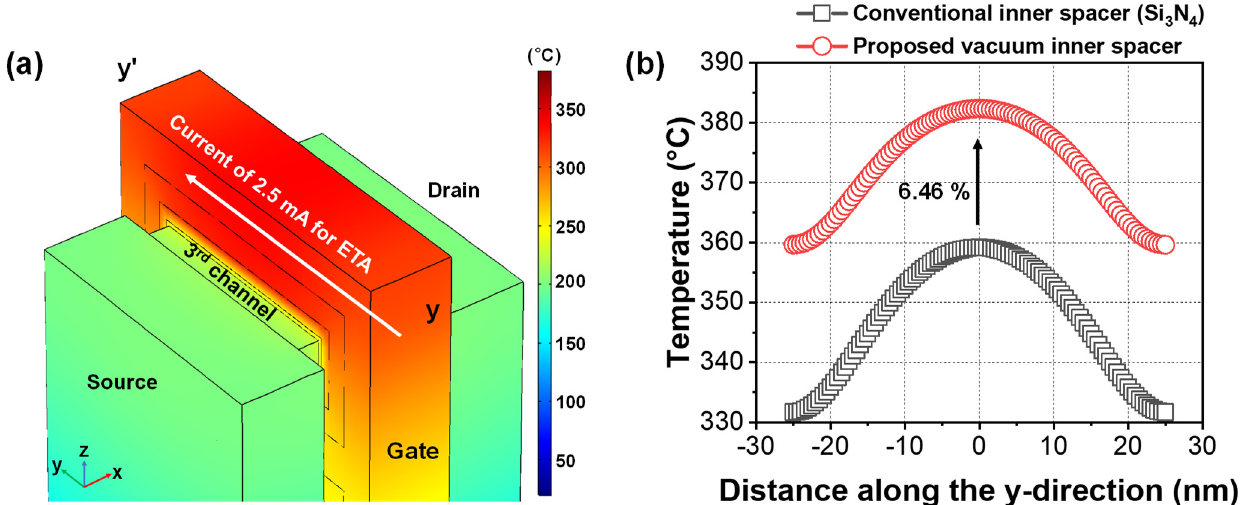
Figure 2. ( a ) Simulated heat distribution profile during ETA using gate-to-gate current in an NS FET. ( b ) Extracted temperature on the gate surface according to inner spacer material.